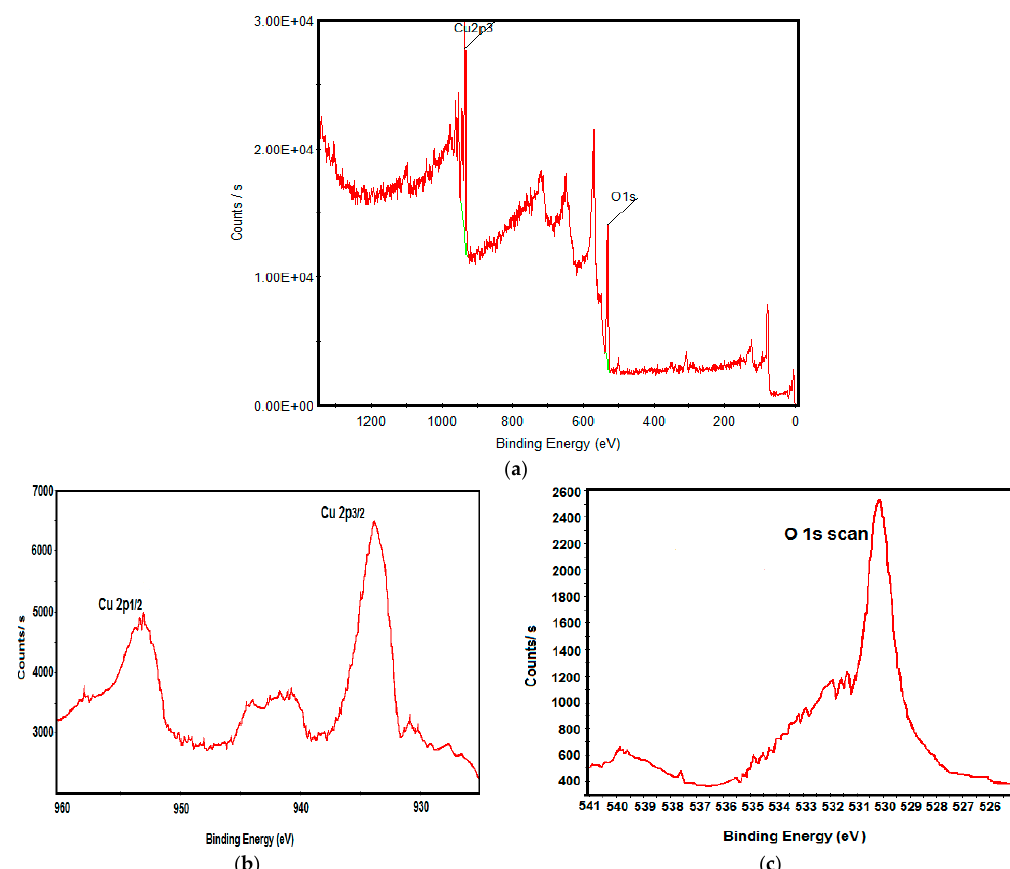
Figure 4. ( a ) X ‐ ray photoelectron spectroscopy (XPS) survey spectrum of P. acerifolium ‐ synthesized CuO nanoparticles; ( b ) Cu 2p scan; ( c ) O 1s scan. Figure 4. ( a ) X-ray photoelectron spectroscopy (XPS) survey spectrum of P. acerifolium